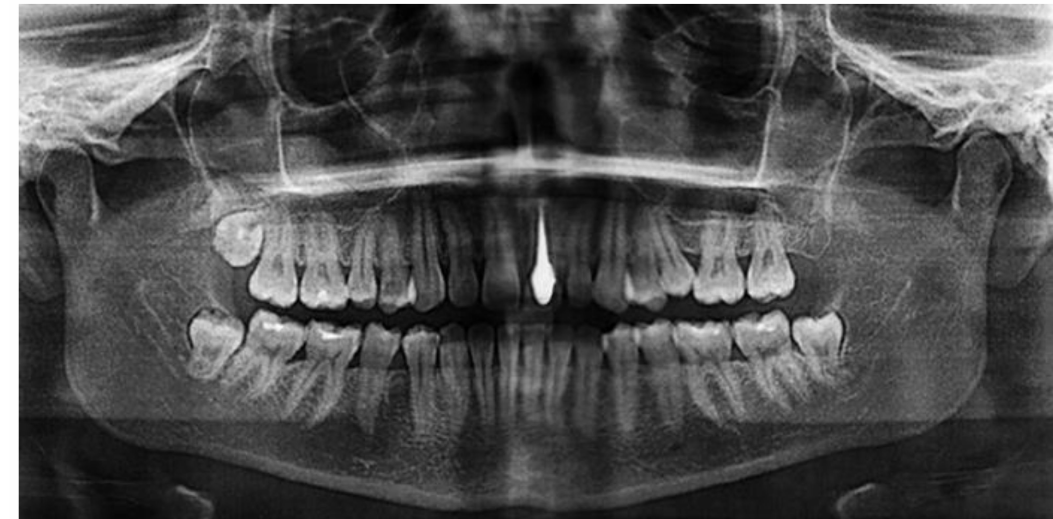
Figure 6. Silicon nitride as a material for dental core restoration, revealing radiolucency [63]. © Creative Commons Attribution 4.0 International